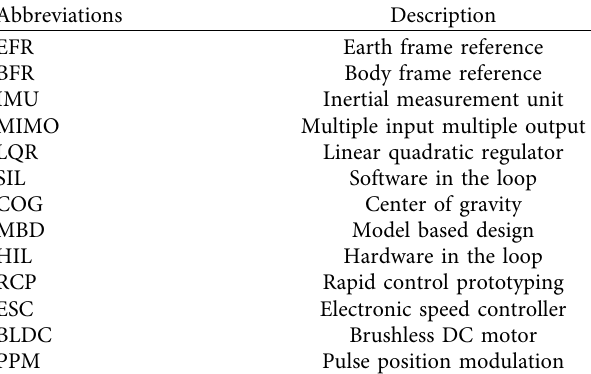
Table 1: List of abbreviations.